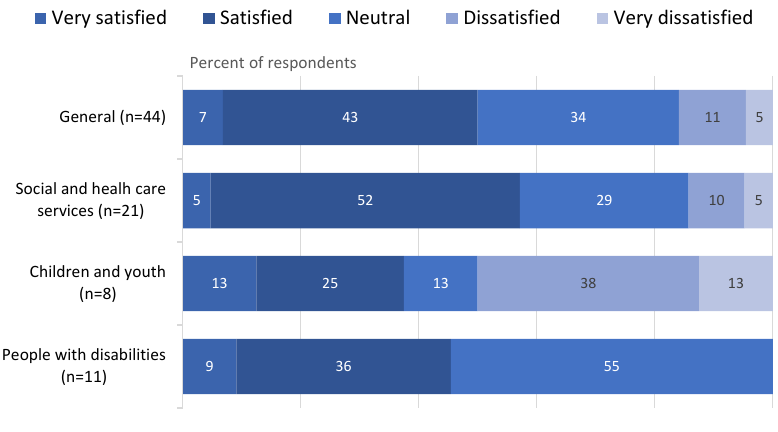
Figure 5: CSOs ’ satisfaction with support from government (social service CSOs in all fields; n = 44), in